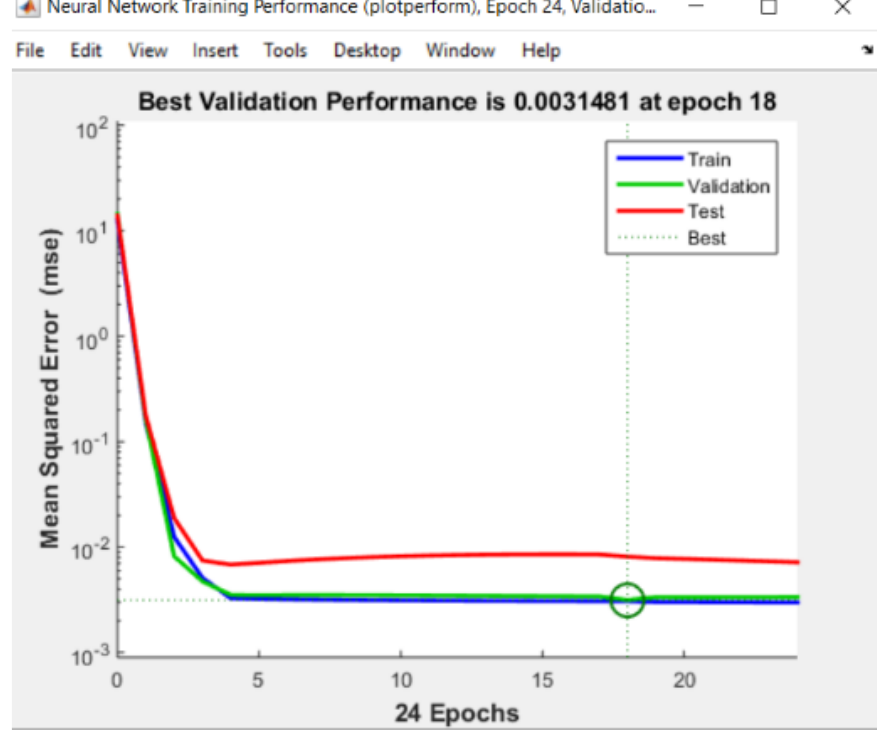
Figure 3. Training process of the neural network.